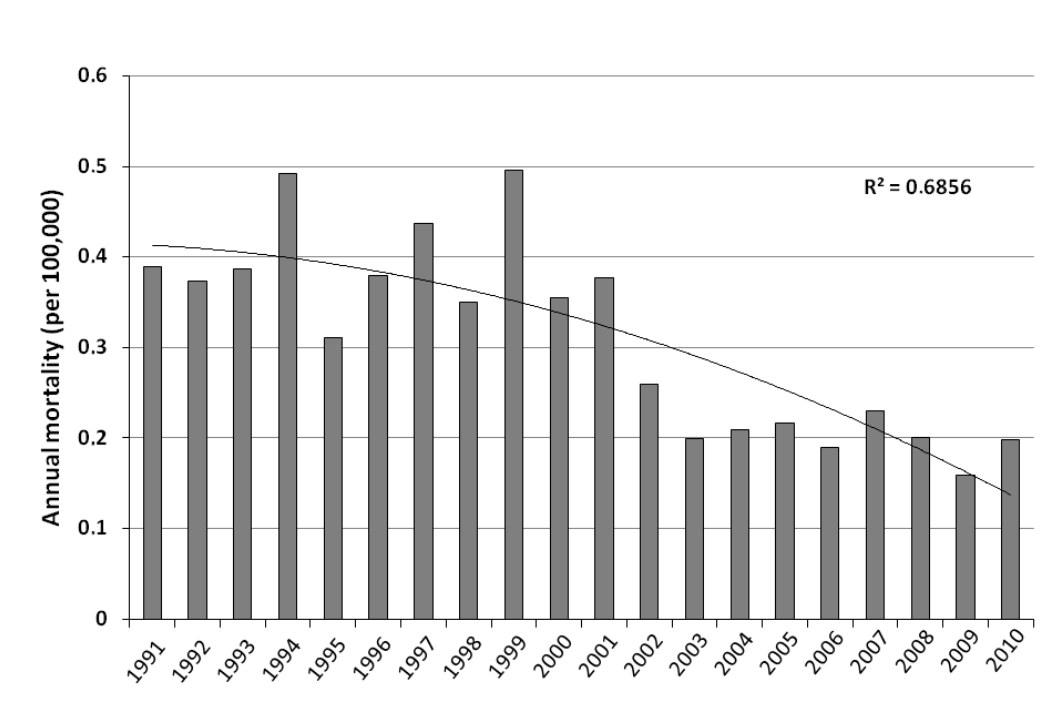
Figure 10. Trend of annual mortality due to scorpion stings in Algeria from 1991 to